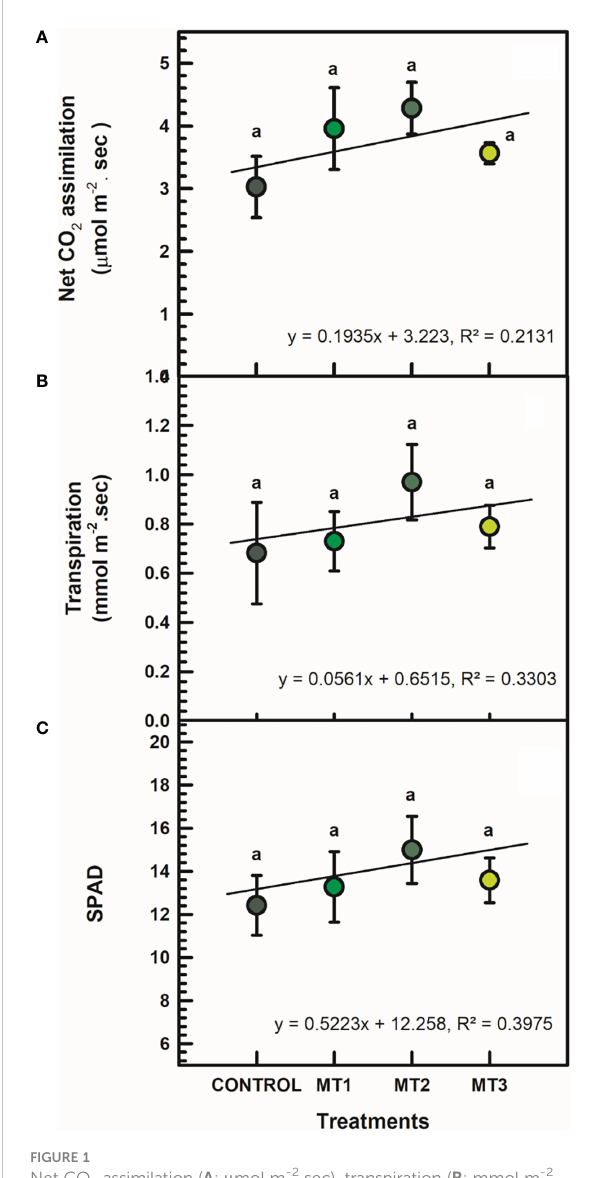
FIGURE 1 Net CO 2 assimilation ( A ; m mol m -2 sec), transpiration ( B ; mmol m -2 sec), and SPAD (C) of tuberose plants treated with preharvest foliar applications of distilled water (control; MT0) and three concentrations of melatonin (MLT): 0.05 mM (MT1), 0.07 mM (MT2), and 1 mM (MT3). Data are means ±SE (n=40). Different letters above the bars indicate signi fi cant differences according to the LSD test at P=0.05.